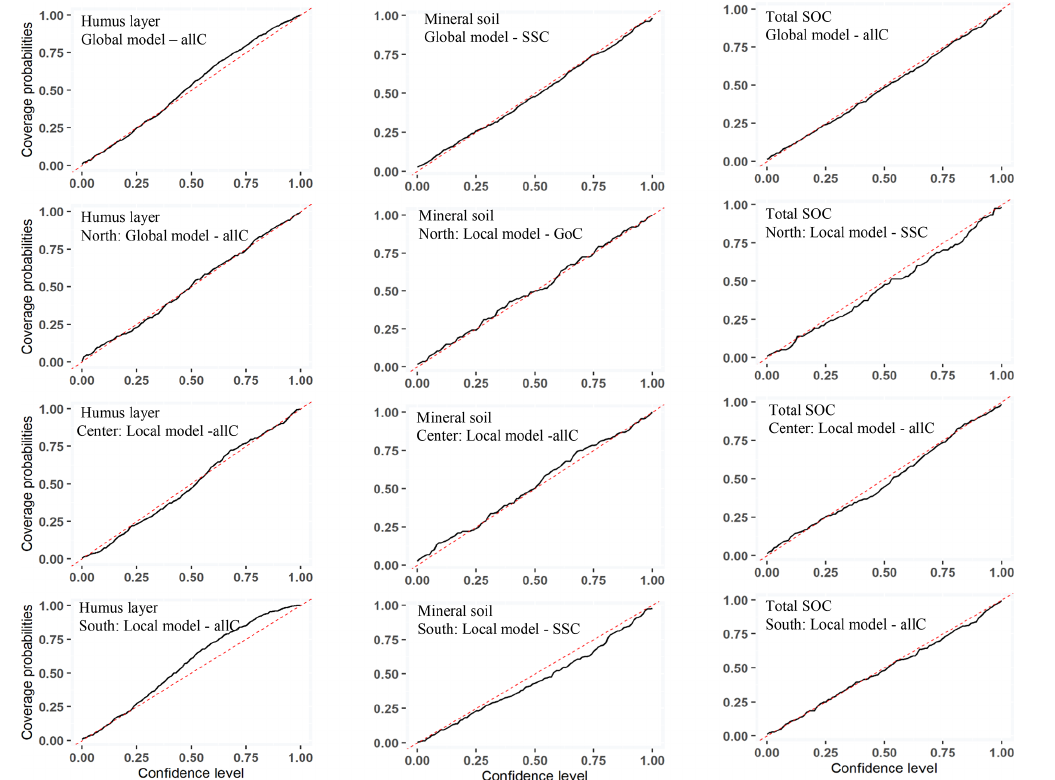
Figure 4. Prediction interval coverage probability of the local and global random models for the humus layer, mineral soil, and total SOC stock. SSCs – site-specific covariates; GoCs – group of covariates; allCs – all covariates.